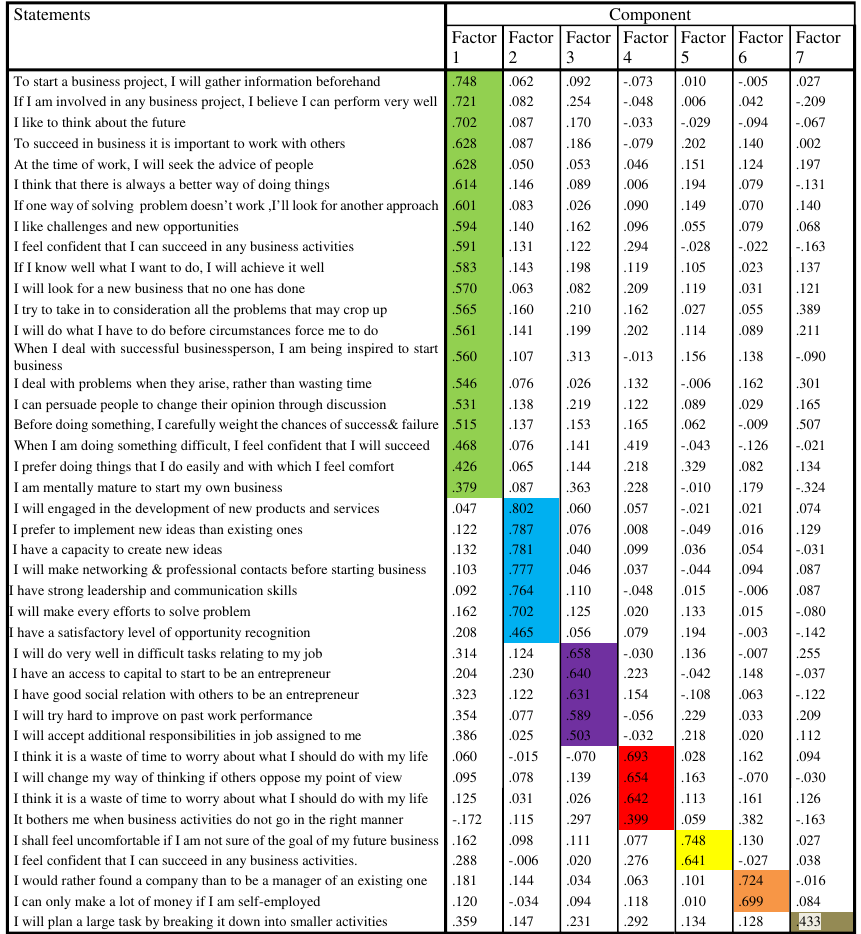
Table 4 Rotated component matrix